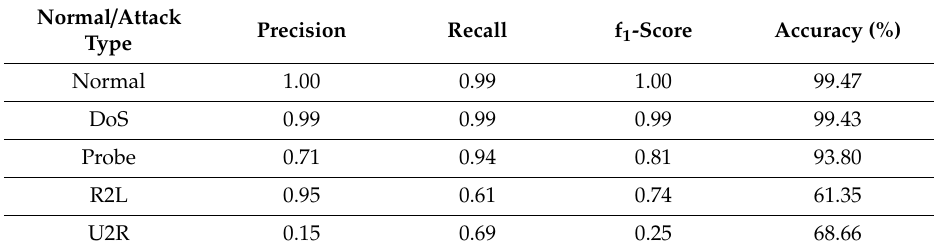
Table 17. Results of the evaluation metrics for multi-class classification using 99 features and 80 neurons in the hidden